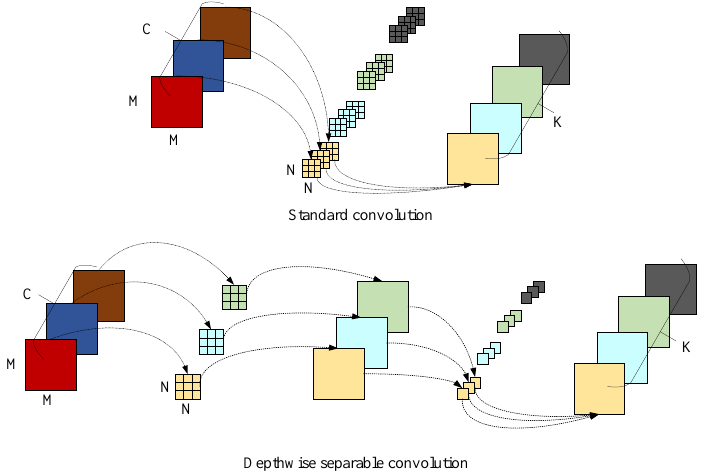
Figure 5. Comparison of general convolution and depthwise separable